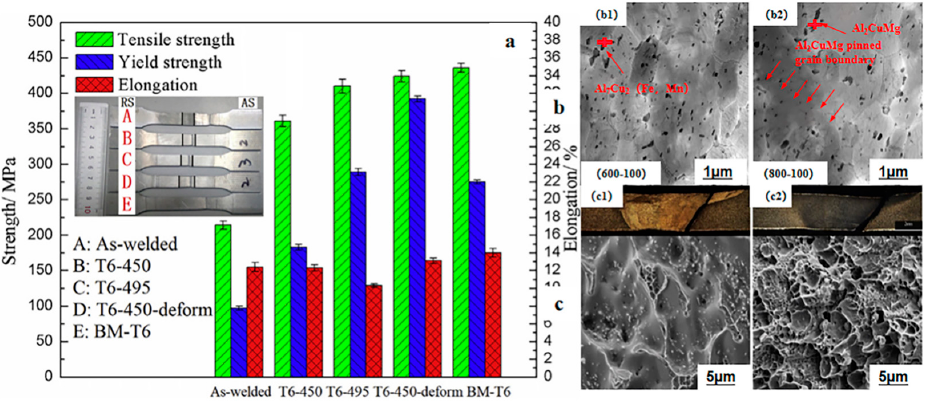
Figure 20. ( a ) Tensile properties of FSW joints under different heat treatment processes (800 rpm, 100 mm/min). ( b ) TEM images of the joints: ( b1 ) FSW joints with 600 rpm and 100 mm/min, ( b2 ) FSW joints with 800 rpm and 100 mm/min. ( c ) Appearances of fracture surfaces for FSW joints: ( c1 ) T6-495 joint, ( c2 ) T6-450 deformed joint [101].